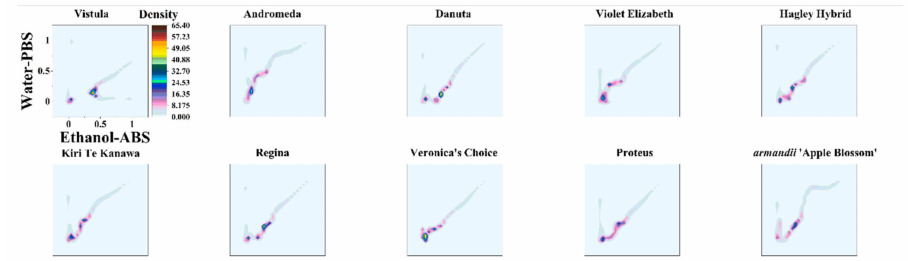
Figure 5. 2D density plots of Vistula, Andromeda, Danuta, Armandii ‘Apple Blossom,’ Proteus, Hagley Hybrid, Violet Elizabeth, Kiri Te Kanawa, Regina, and Veronica’s Choice using data recorded from the 0.1 M PBS after water extraction vs. the 0.1 M ABS after ethanol extraction.